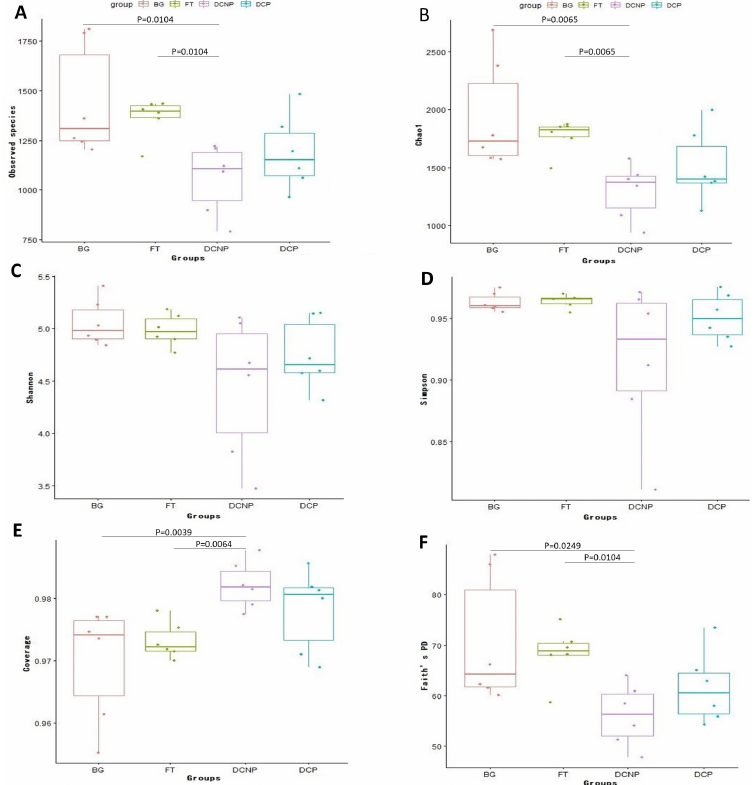
Figure 4. Heatmap of high abundance at genus level in the four groups.